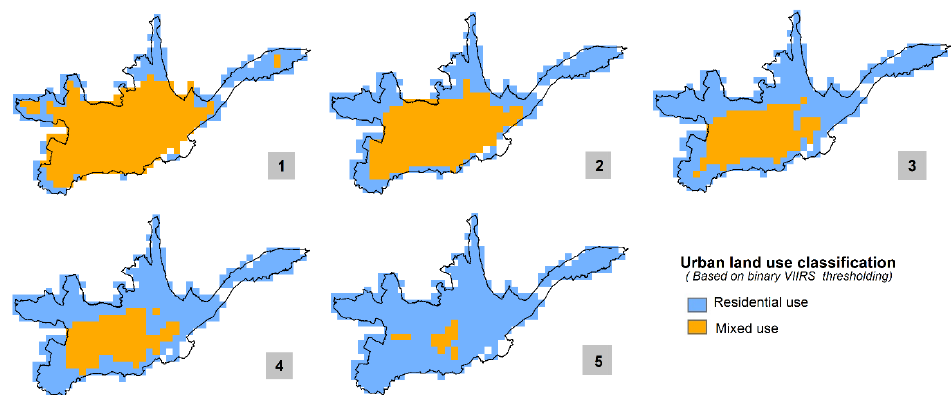
Figure 7. Binary land use classification of Cuenca City based on thresholds from original VIIRS data (Table 2). Blue indicates residential and orange mixed use. Table record IDs are indicated in the figure as 1–5.